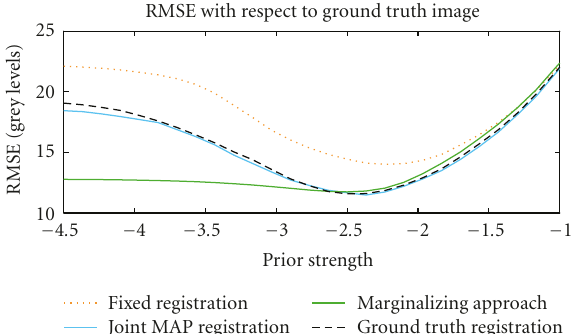
Figure 10: Plot showing the variation of RMSE with prior strength for the fixed Huber MAP method and our approach integrating over θ and λ , applied to the synthetic dataset of Figure 9. As well as reach- ing a lower minimum, the integrating approach appears to be more consistent across variations in prior strength.